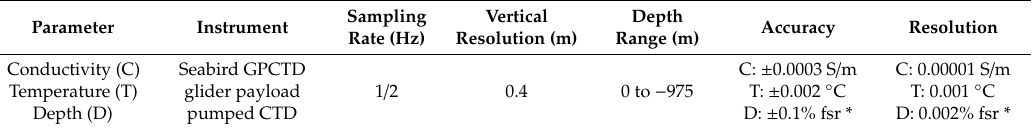
Table 1. Sampling rate and vertical resolution of ABACUS gliders’ conductivity-temperature-depth (CTD) sensors (* full scale